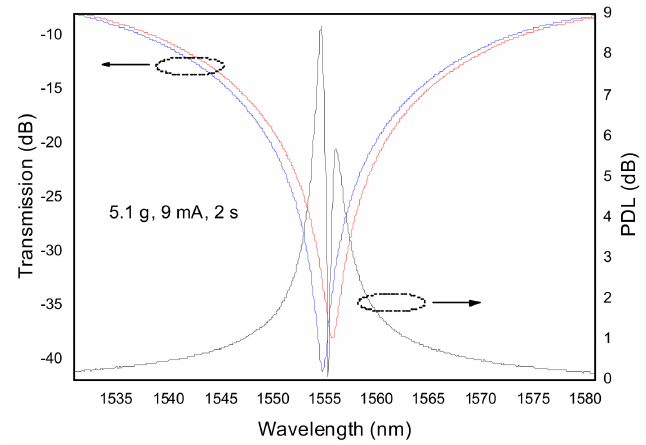
Figure 15. Transmission loss of LP 14 resonance and respective PDL, inscribed using the following set of fabrication parameters: 5.1 g, 9 mA, 2 s and 30. Adapted with permission from ref. [81]. © 2021 Elsevier.